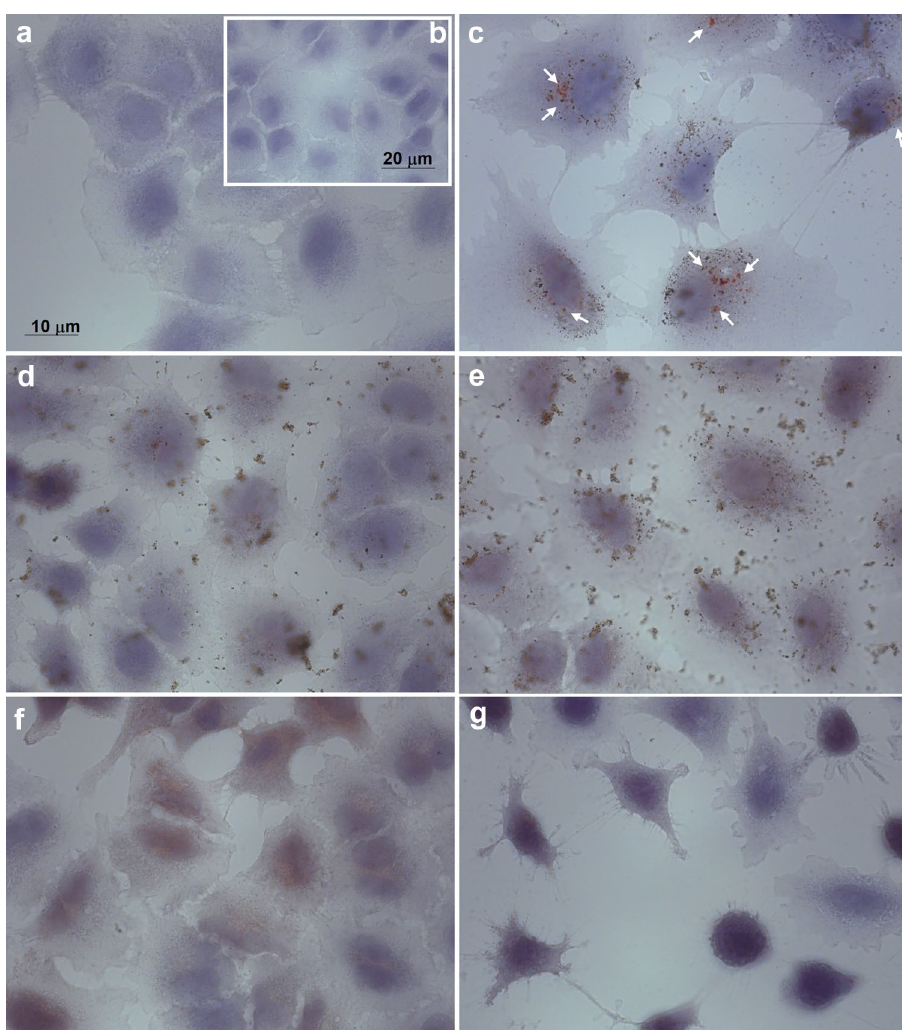
Figure 8. Cytochemistry of intracellular Cu ++ by Rhodanine staining in A549. ( a ) negative control (unexposed cells); ( b ) Cu ++ -exposed cells (from CuSO 4 ·5H 2 O); ( c ) Positive control (10 µg/ml cCuO-BSA -treated cells, 24 h post-exposure)—red spots (white arrows) testify for the intracellular release of Cu ++ from NPs; ( d , e ) 25 µg/ml cCuO-treated cells at 1 h and 3 h post-exposure, respectively; ( f , g ) 25 µg/ml sCuO-treated cells at 1 h and 3 h post-exposure,